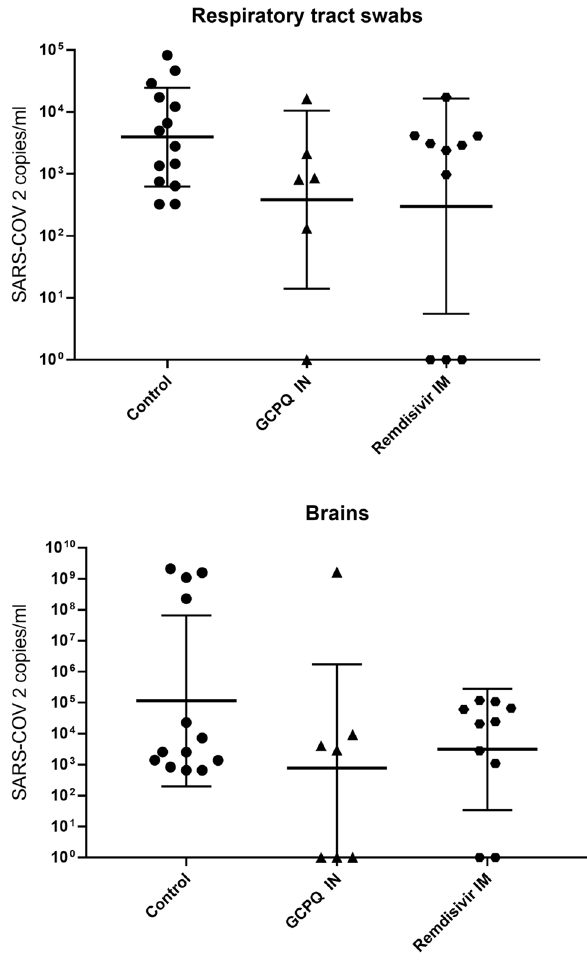
Figure 6. Viral titres in transgenic mice expressing the human ACE2 protein under the human cytokeratin 18 promoter (n = 10–14) following the nasal dosing of GCPQ once daily (20 mg/kg) and intramuscular remdesivir at a single daily dose of 25